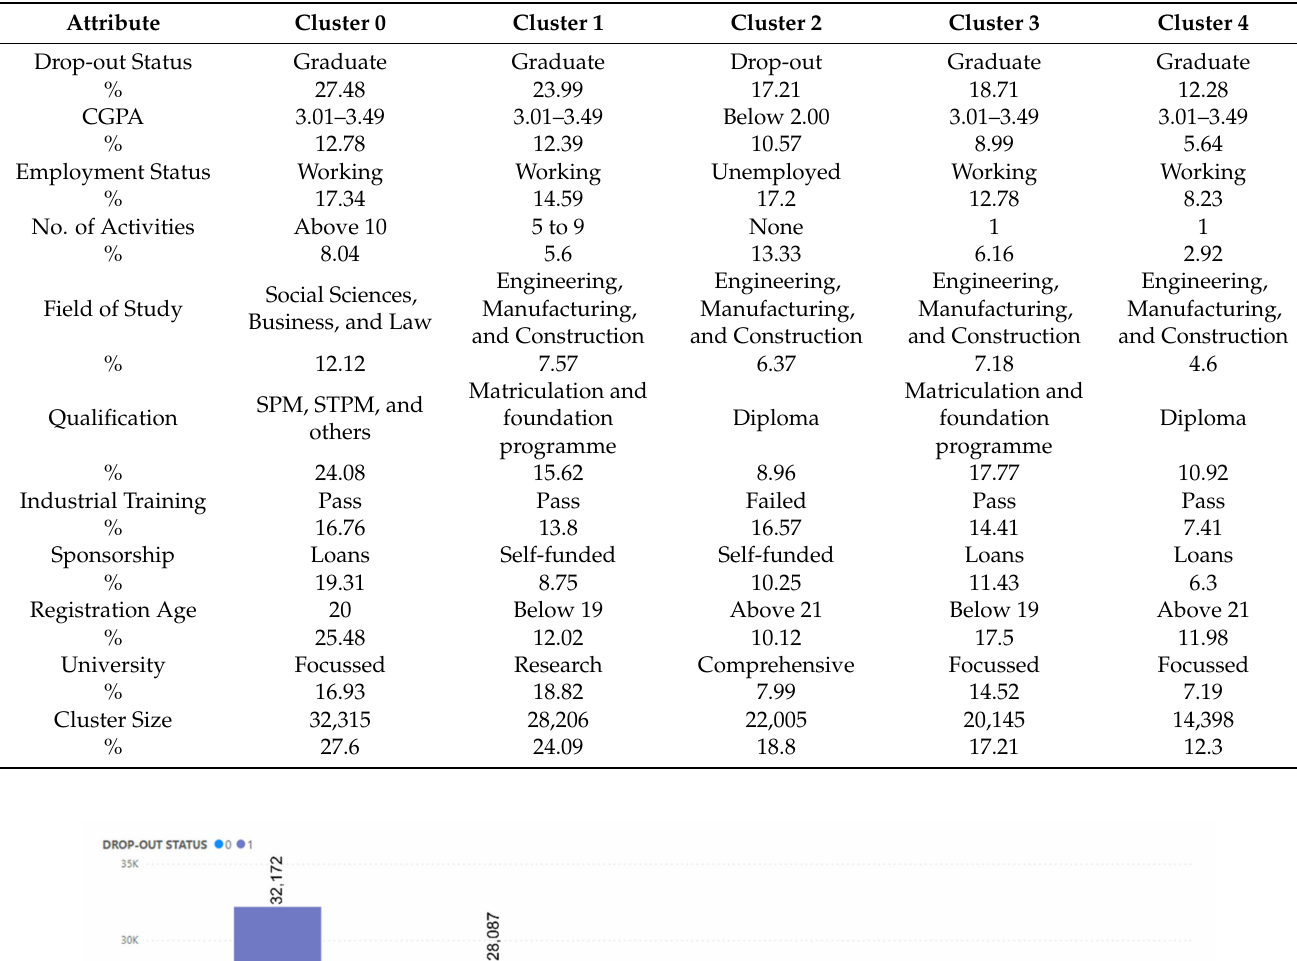
Table 10. Descriptive statistics from the clustering result for the KMoB.